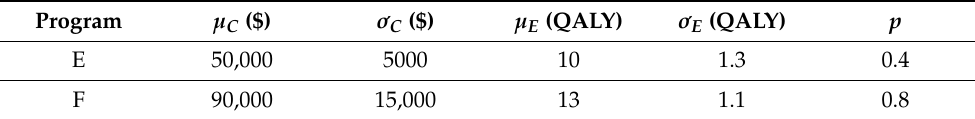
Table 1. Costs and effects of two hypothetical